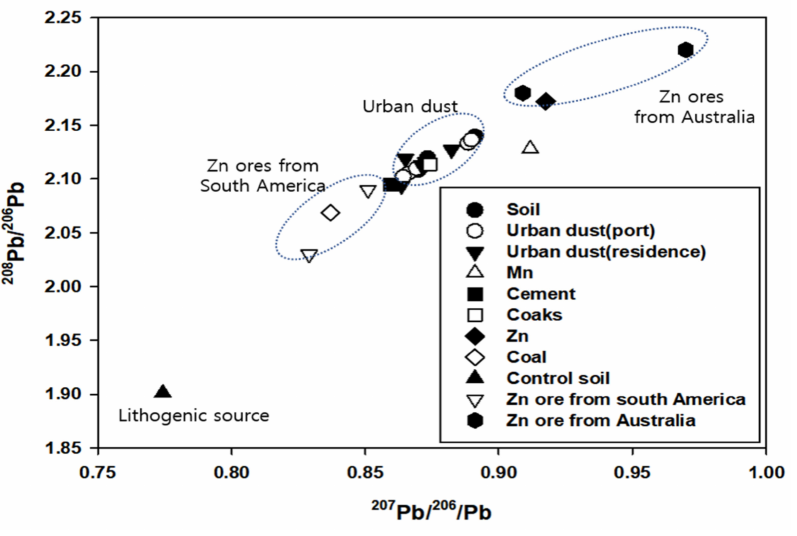
Figure 4. Relationship between 208 Pb/ 206 Pb and 207 Pb/ 206 Pb of soil and urban dust in Donghae port. As a result of the evaluated contribution of pollutant sources on deposited dust through the Iso-source and SIAR models using the stable isotope ratios ( 13 C, 207/206 Pb), we found that the largest contribution was derived from Mn (20.4%) and Zn (20.3%) from industrial factories (Figure 5). These results are consistent with the results of high concentrations of Mn and Zn in the urban dust mentioned above. In previous studies, Pb or C isotope ratios alone were used to trace pollution sources, but this is the first study to identify pollutants using both isotopes